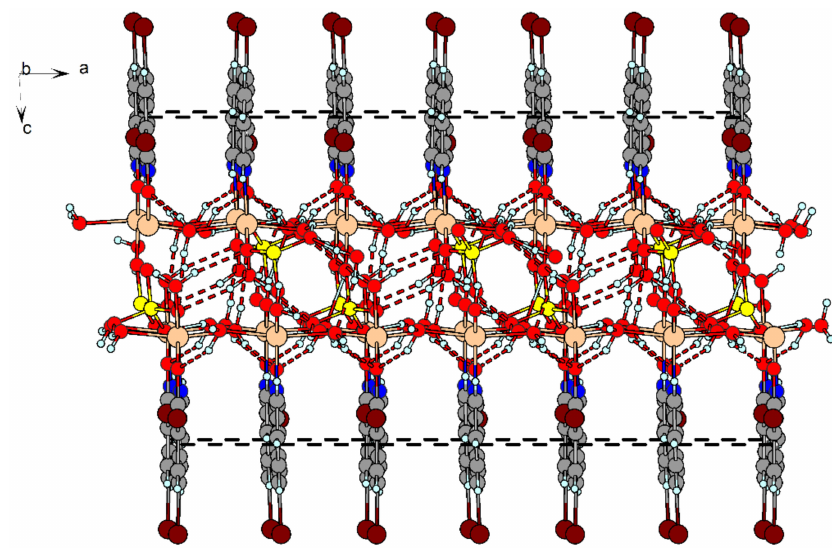
Figure 10. Part of the two-dimensional structure of 5 viewed along the b axis with hydrogen bonds (red dashed lines) and π - π interactions (black dashed lines).